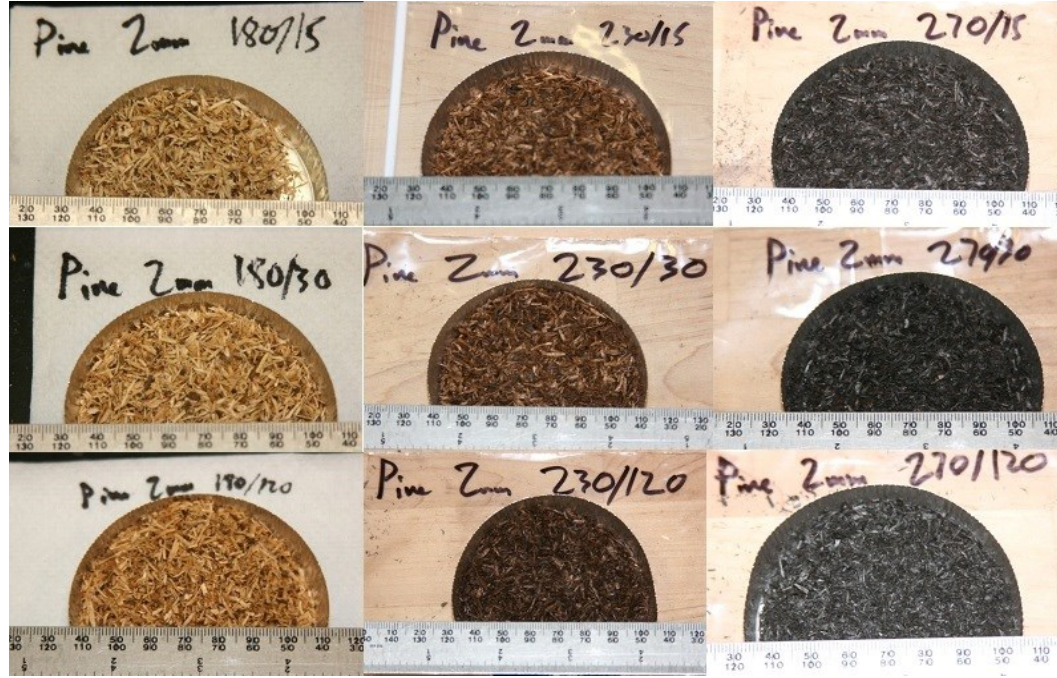
Figure 3. Color changes in torrefied lodgepole pine grind at different torrefaction temperatures and residence times.